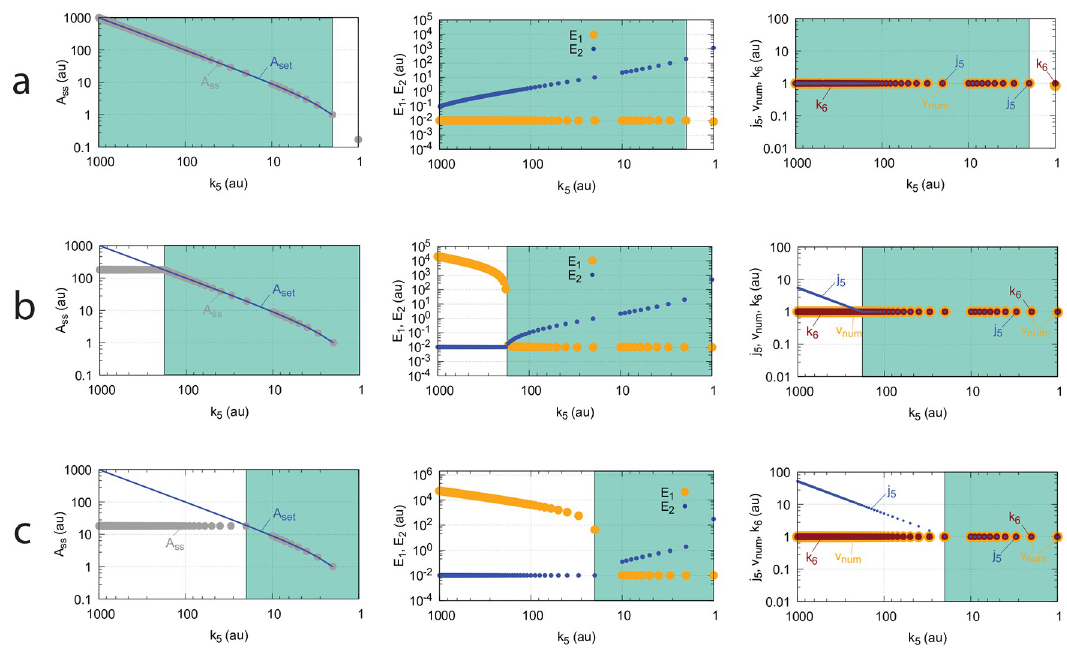
Fig 23. Influence of k 2 on the operational range of the m4 controller Fig 19. See Fig 22 for explanation of symbols. (a) k 2 = 50.0, (b) k 2 = 500.0, (c) k 2 = 5000.0. Other rate constants and initial concentrations are as in Fig